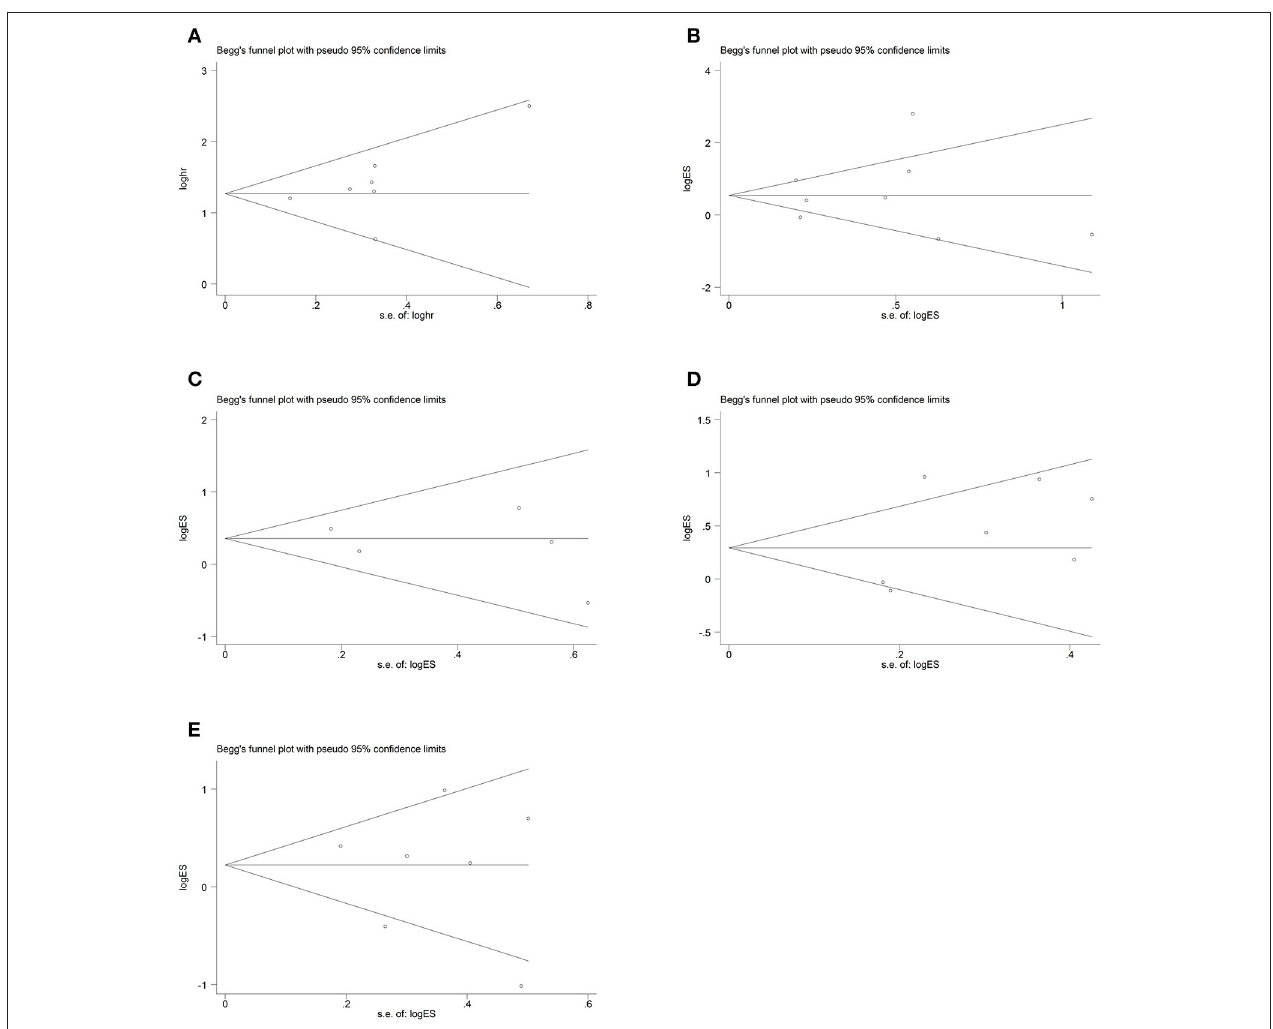
FIGURE 5 | Begg’s test for publication bias. (A) overall survival; (B) Histologic grade; (C) Distant metastasis; (D) Lymph node metastasis; (E) TNM